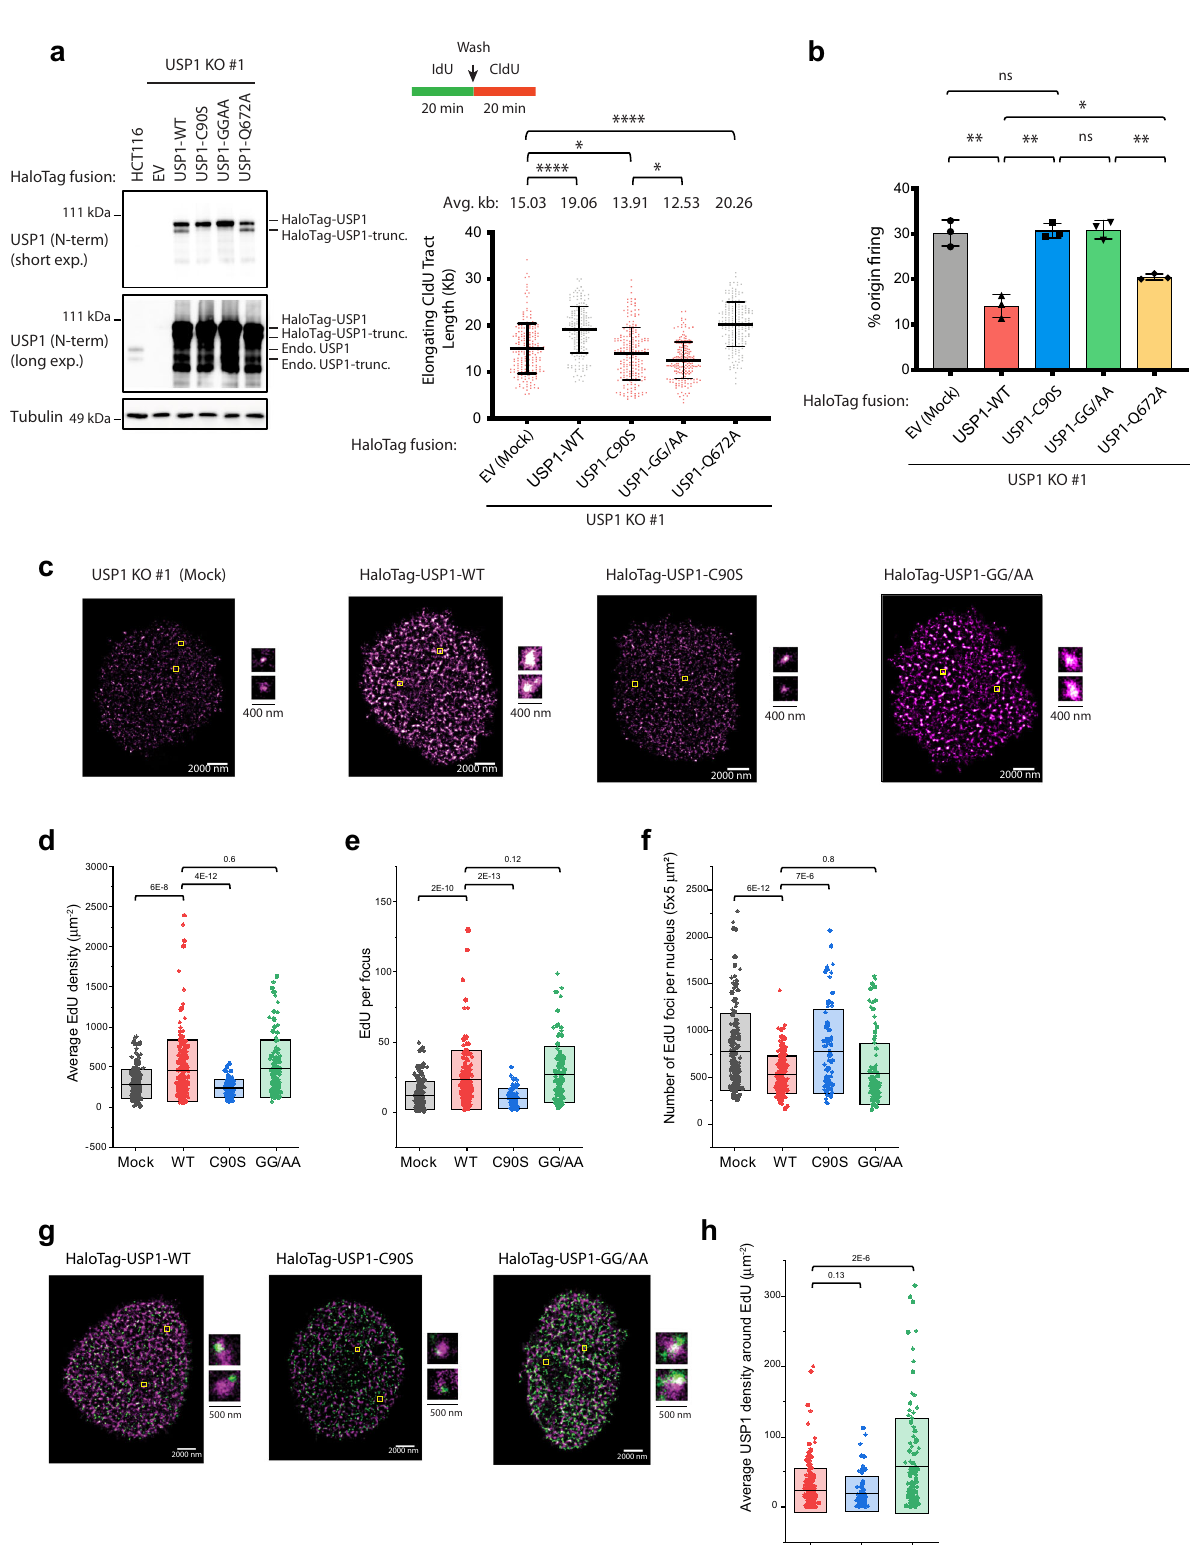
replication foci is a likely contributor to increased replication stress in the USP1-GG/AA mutant cells. Spartan mediates the removal of trapped USP1 mutants from DNA . We were intrigued by our fi ndings that while the